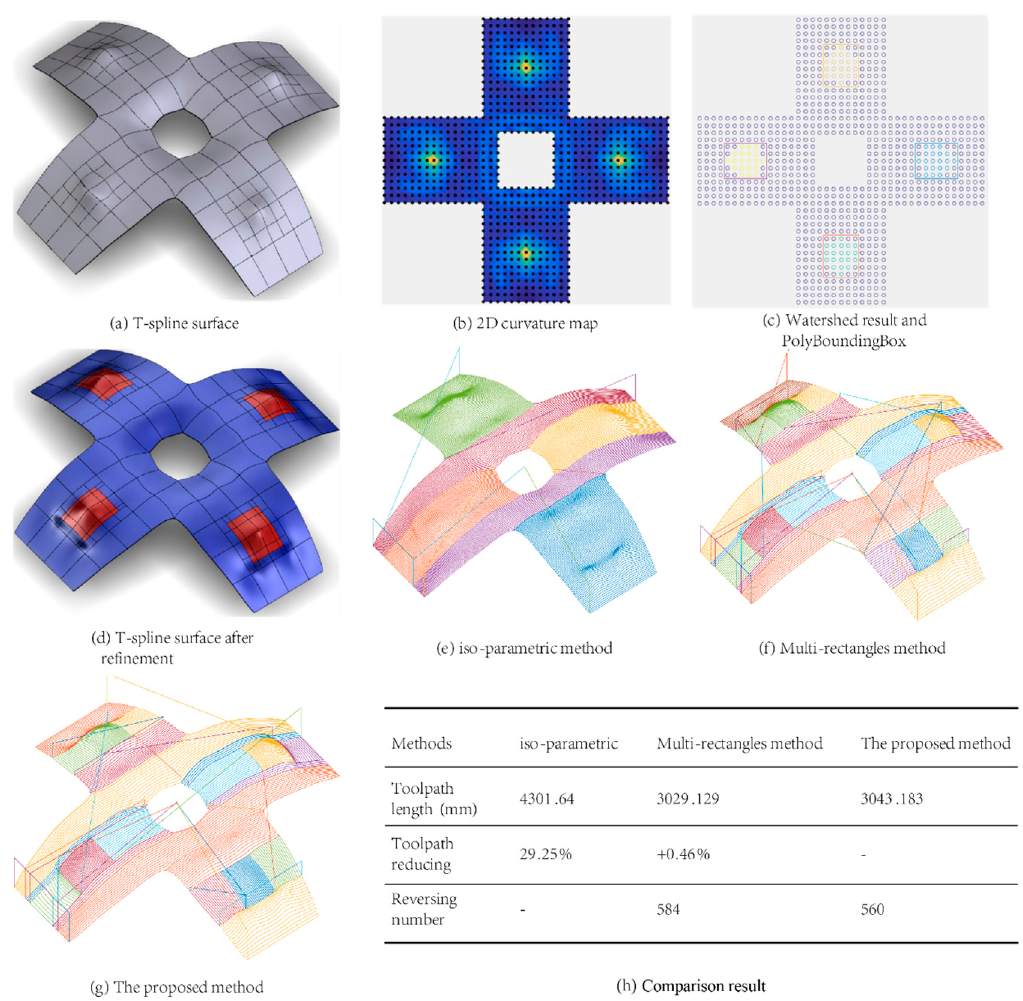
Figure 9. Demonstration and comparison of watershed-based toolpath generation of T-spline surface 3. Table 1. Machining time of toolpath simulation.